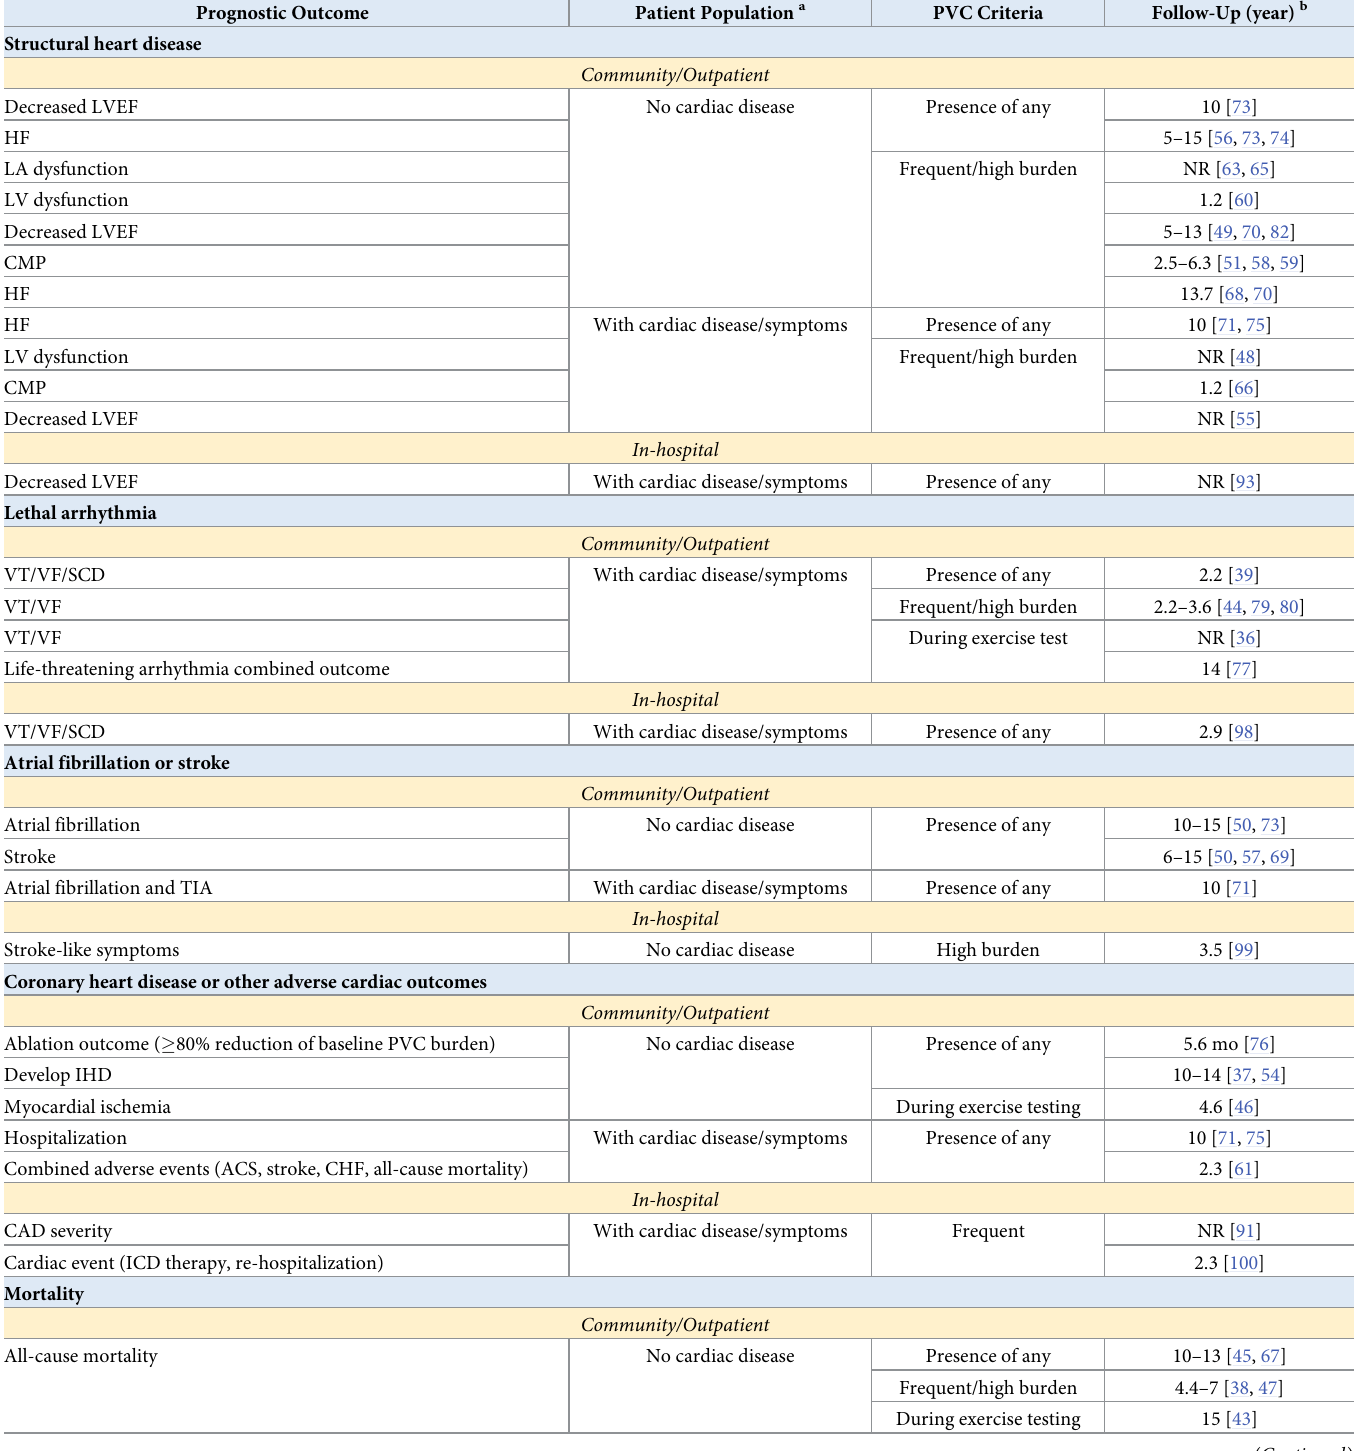
Table 4. Prognostic significance of premature ventricular complexes (PVCs) based on the setting, patient population, and PVC